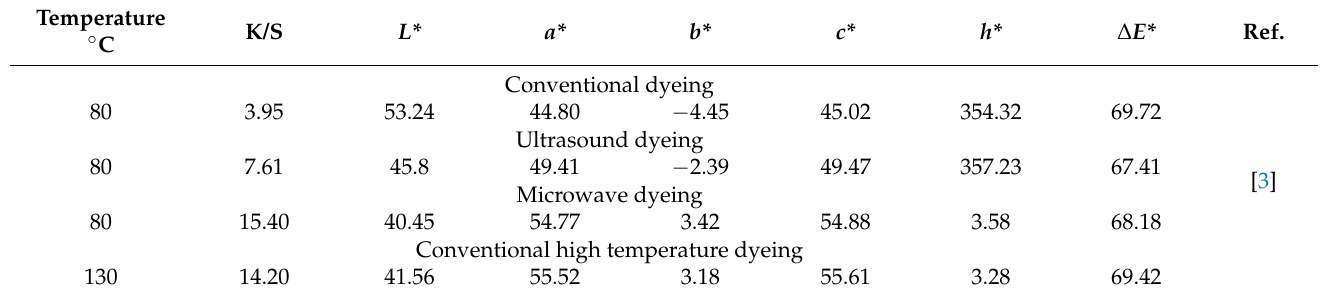
Table 5. Comparison between cconventional, ultrasound dyeing and microwave dyeing methods. Temperature ◦